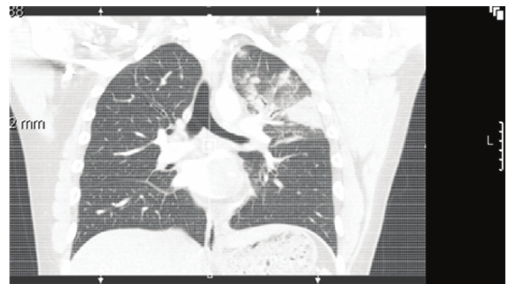
Figure 2: Computer tomogram of chest showing left atrial mass extending into pulmonary vein with left upper lobe lung consolidation.